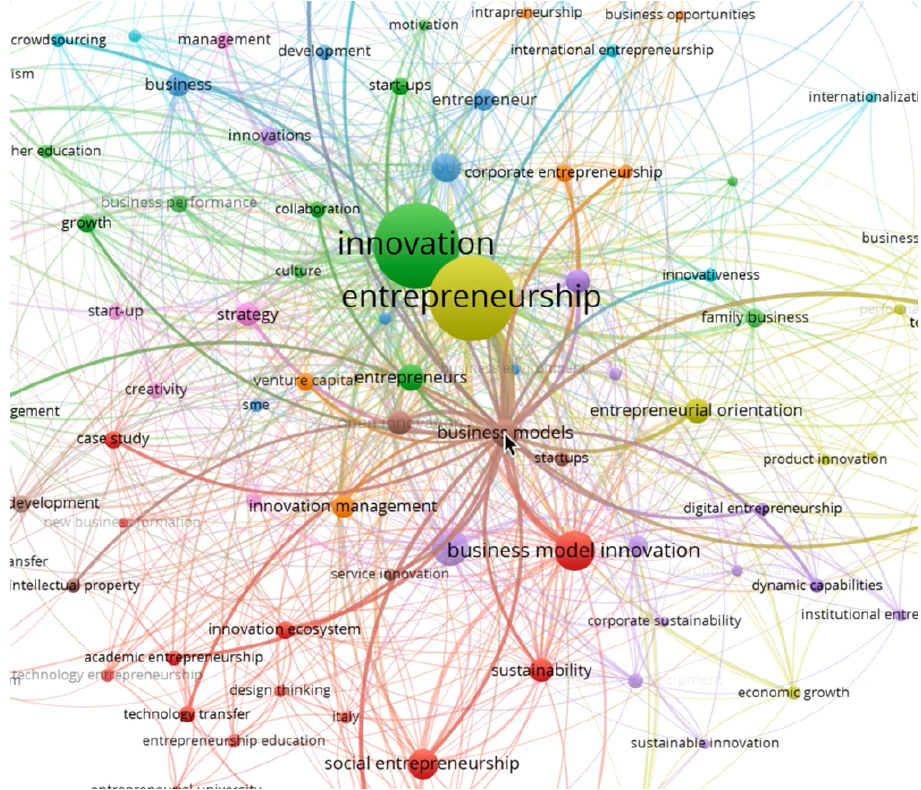
Fig. 3. Keyword co-occurrence map. The selection of one node highlights the node connections for easier